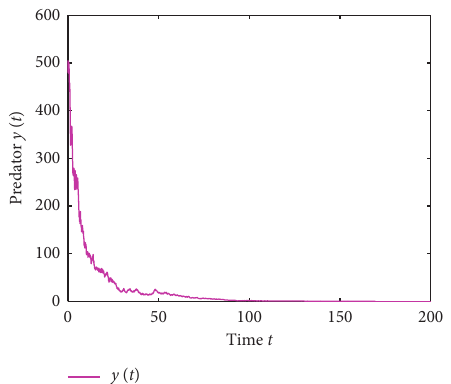
Figure 16: The trajectories of (5) with σ 2